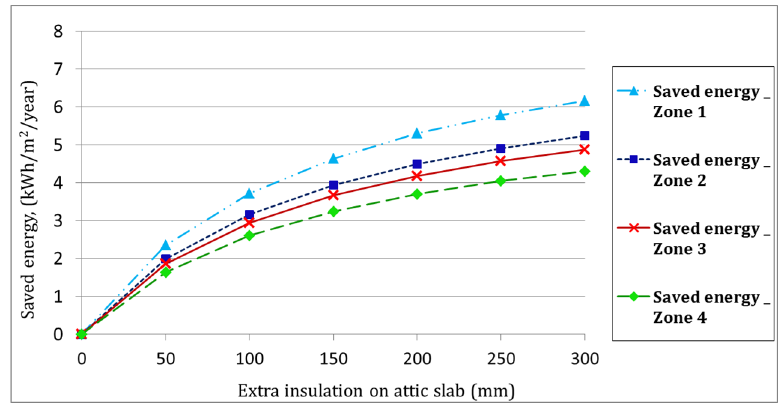
Table 7. Additional insulation materials on exterior walls, assuming a 3% discount rate and a 50-year lifespan (an example for the calculation steps).